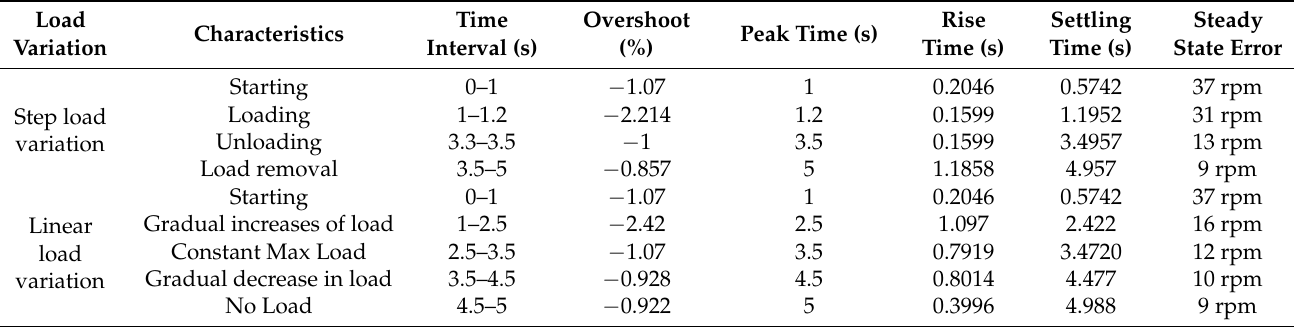
Figure 9. Transient behavior of five-phase PMBLDC motor with ANFIS controller. Table 5. ANFIS Controller Characteristics.